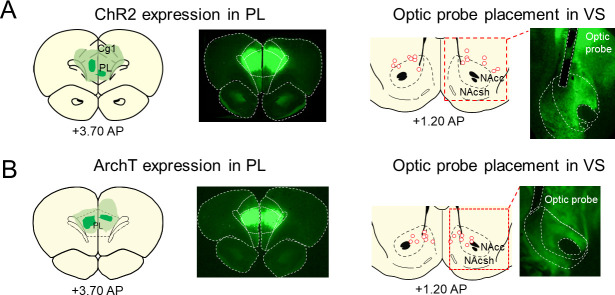
Spread of AAV expression and location of optic probes.(A) Min/max spread of AAV expression with example micrograph. (B) Location of optic fiber tips with example micrograph for each projection tested.